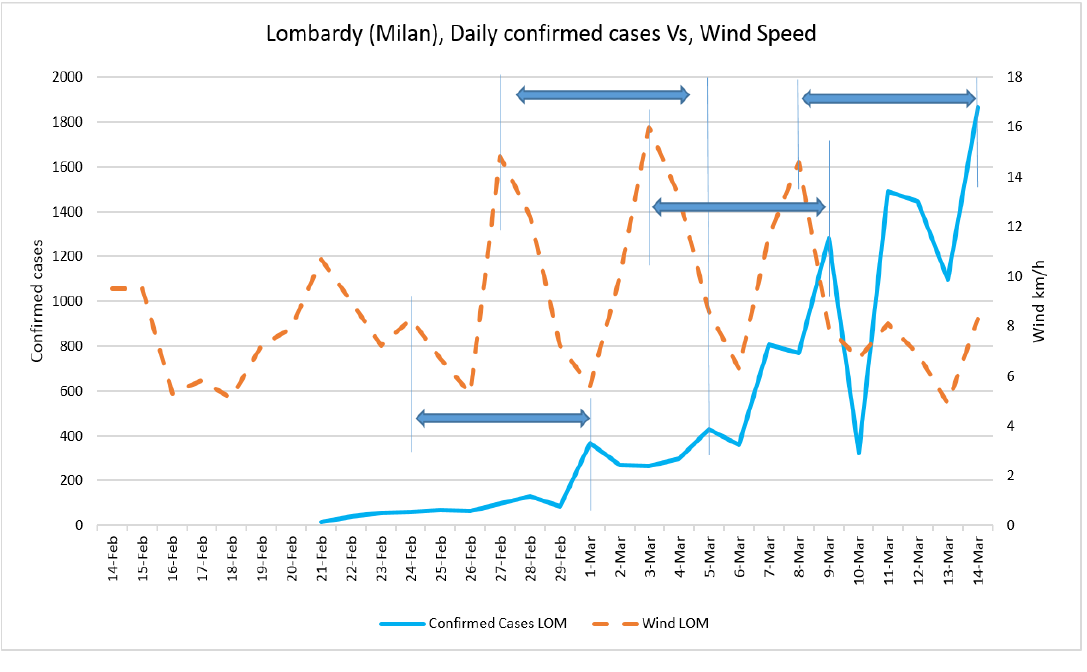
Figure 5. Daily confirmed cases of COVID-19 in Lombardy and wind speed.